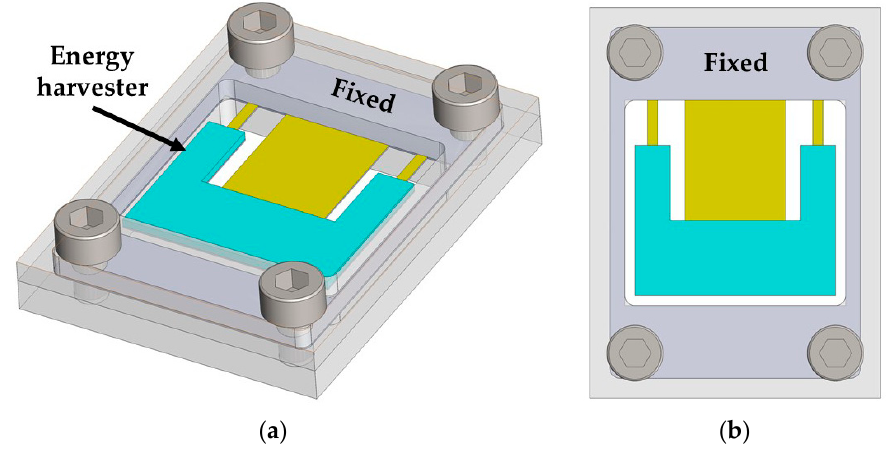
Figure 1. 3D design of the piezoelectric vibration energy harvesting (pVEH) microdevice for air conditioning vents at office buildings, considering isometric ( a ) and plant ( b ) views.